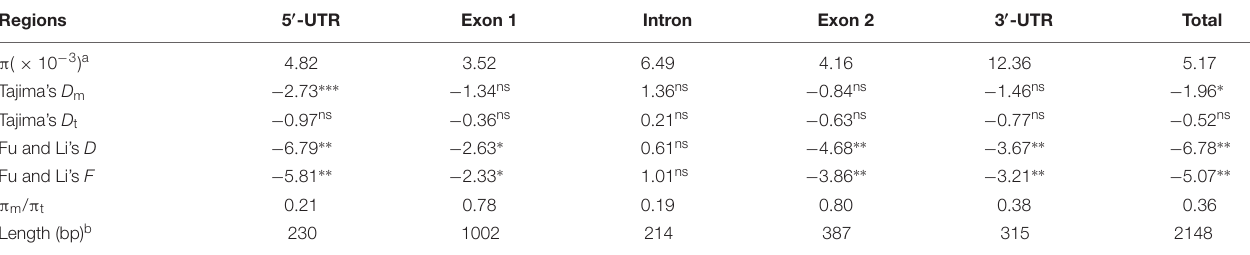
TABLE 1 | Summary of natural variation and neutrality test of ZmARF31 in maize and teosinte. Regions